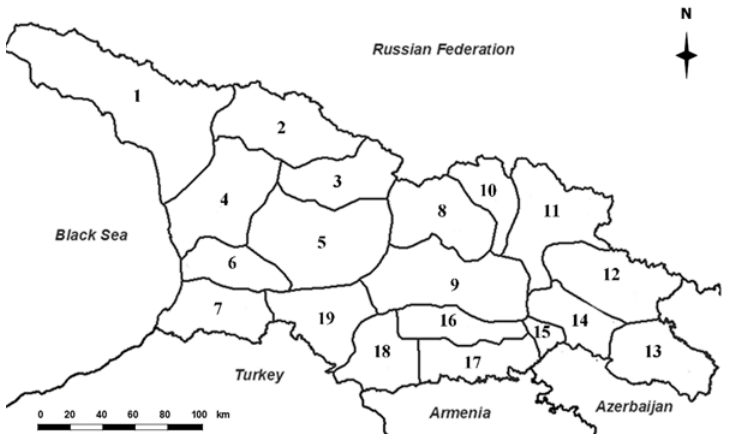
Figure 1 Schematic map of the floristic regions of Georgia according to Kec ʻ xoveli et